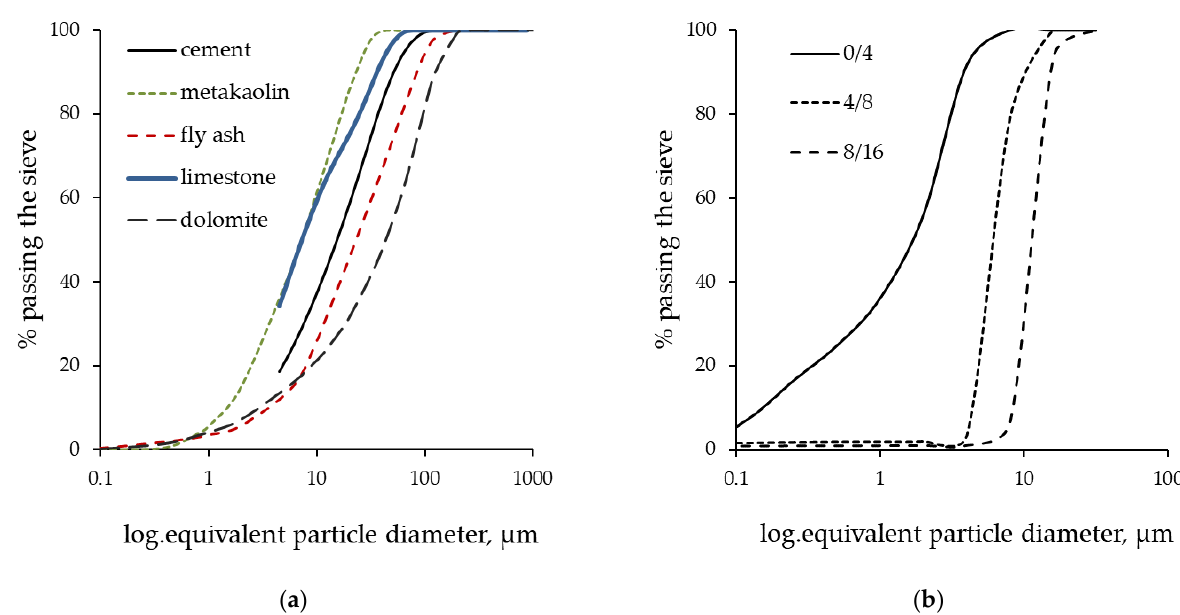
Figure 1. Granulometry of the ( a ) binder materials and dolomite filer, ( b ) aggregate. Table 1. Properties of binder